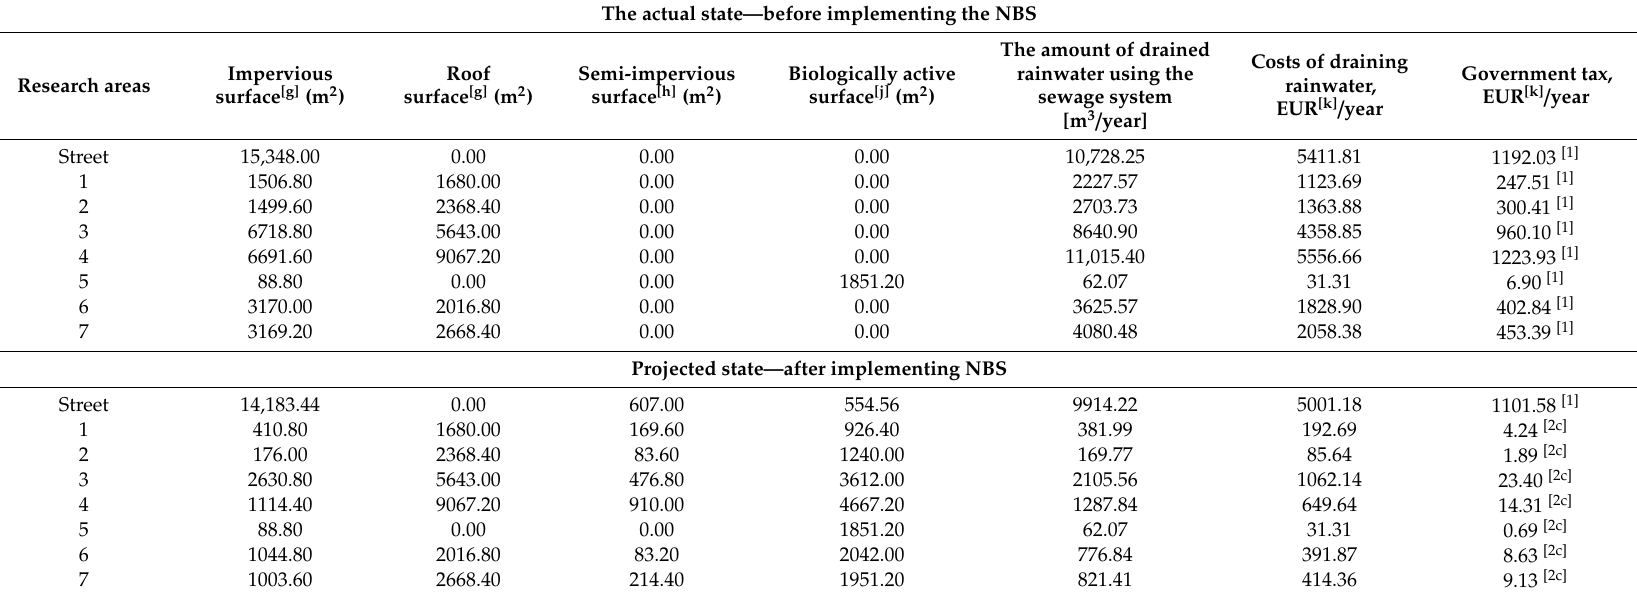
Table 2. The cost of draining rainwater and the government tax depending on the amount of drained water. The actual state—before implementing the